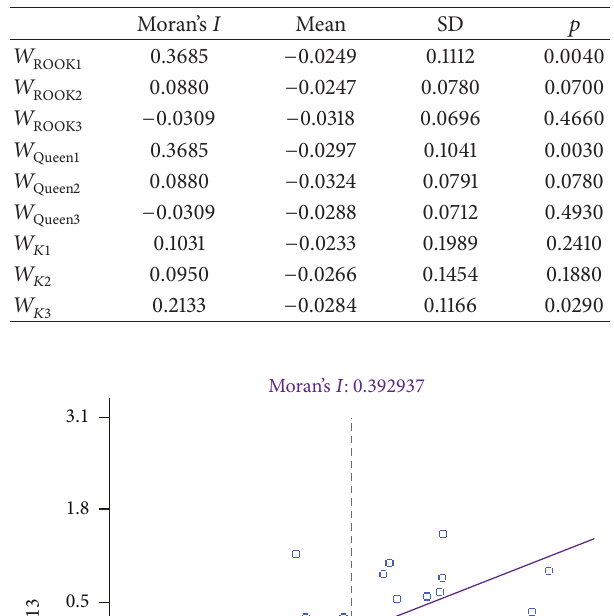
Table 1: Global Moran’s index for space autocorrelation for forestry productions in different regions.